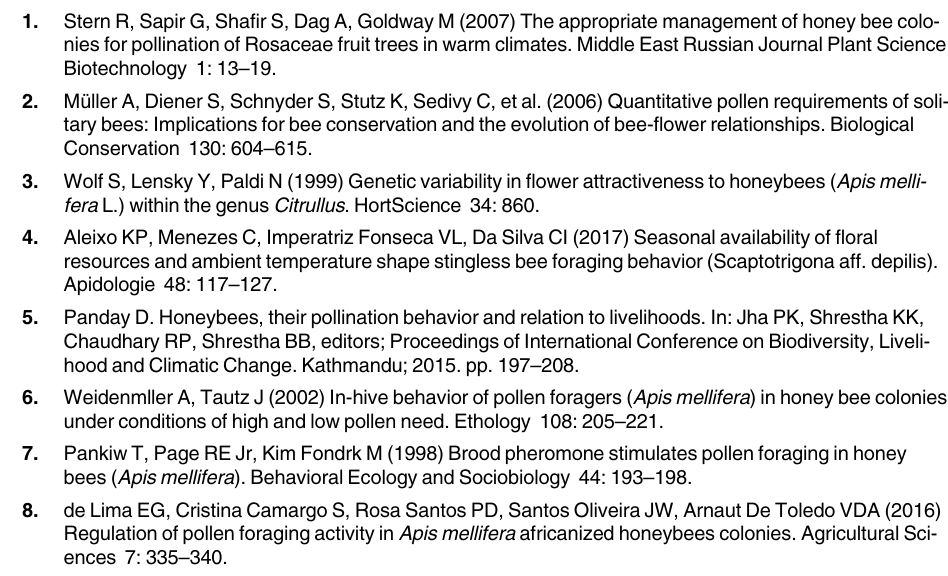
S1 Fig. Different color of pollen collected by honey bees.